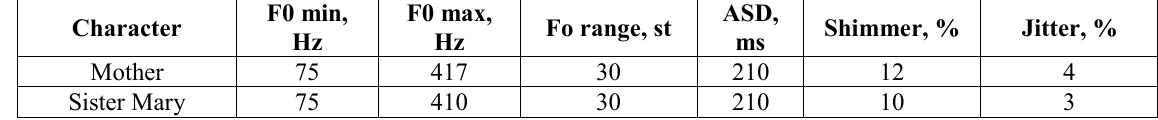
Table 2. Prosodic characteristics of adult female voices (n=2)